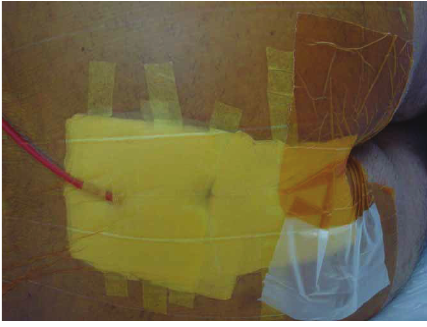
Figure 3: The wound with simple vacuum assisted dressing in place.